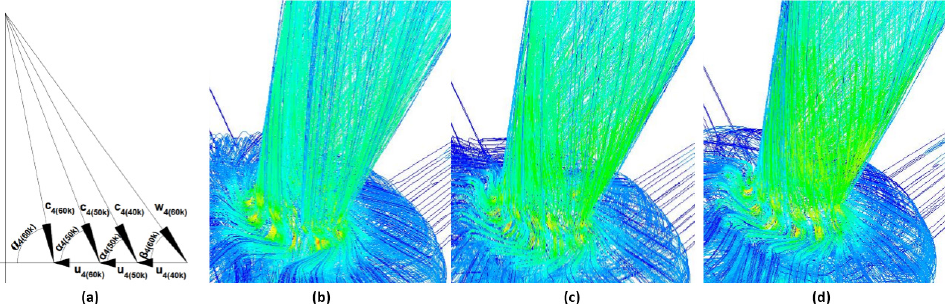
Figure 36. ( a ) Configuration of velocity triangles at the outlet from the 2nd stage rotor, ( b ) outlet velocity pathlines at 60,000 rpm, ( c ) outlet velocity pathlines at 50,000 rpm, ( d ) outlet velocity pathlines at 40,000